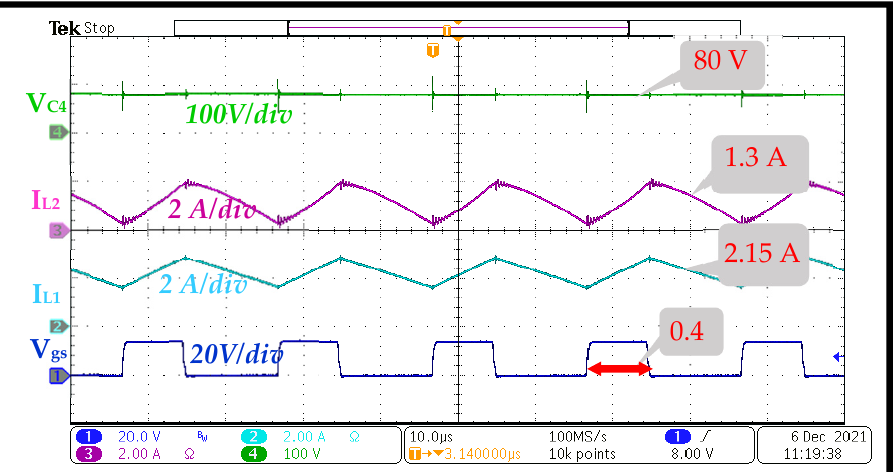
Figure 23. The experimental waveform of ( 1 ) Duty cycle (V gs ) at d = 0.4, ( 2 ) Inductor (L 1 ) Current (I L1 ), ( 3 ) Inductor (L 2 ) Current (I L2 ), and ( 4 ) Capacitor (C 4 ) voltage ( V C 4 ).